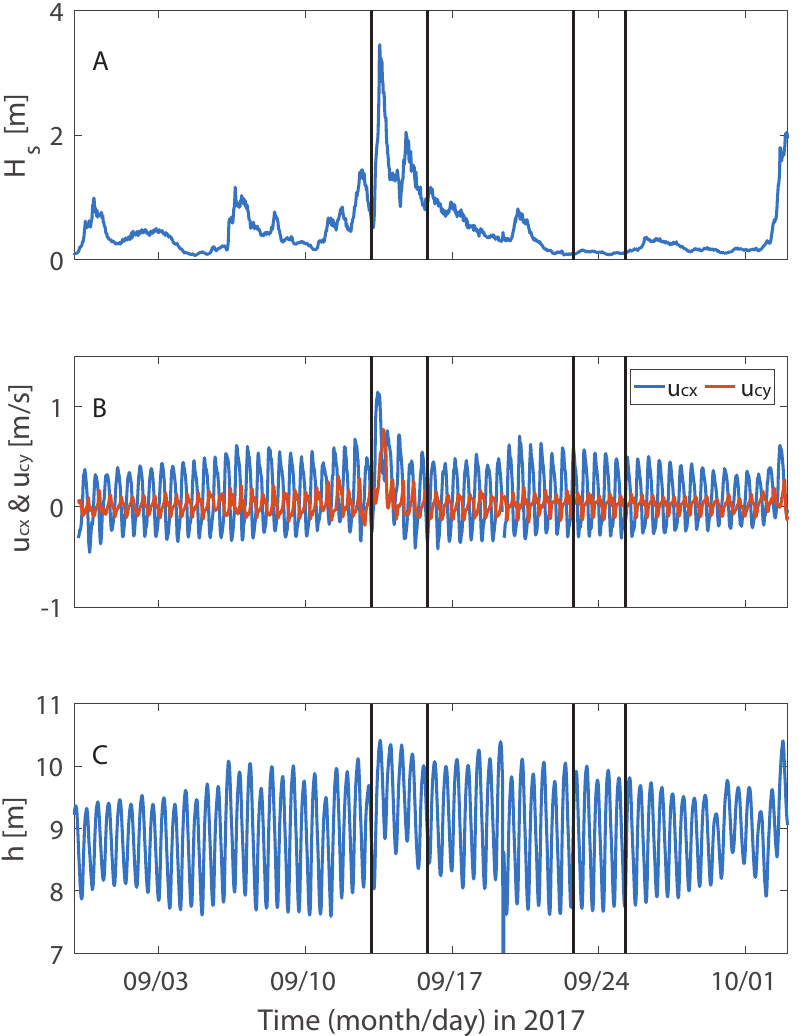
Figure 3. Hydrodynamics as measured at Frame 5. ( A ): significant wave height. ( B ): east ( u cx ) and north ( u cy ) component of the depth-averaged current velocity. ( C ): water depth. Black lines indicate the representative storm and calm period described throughout this